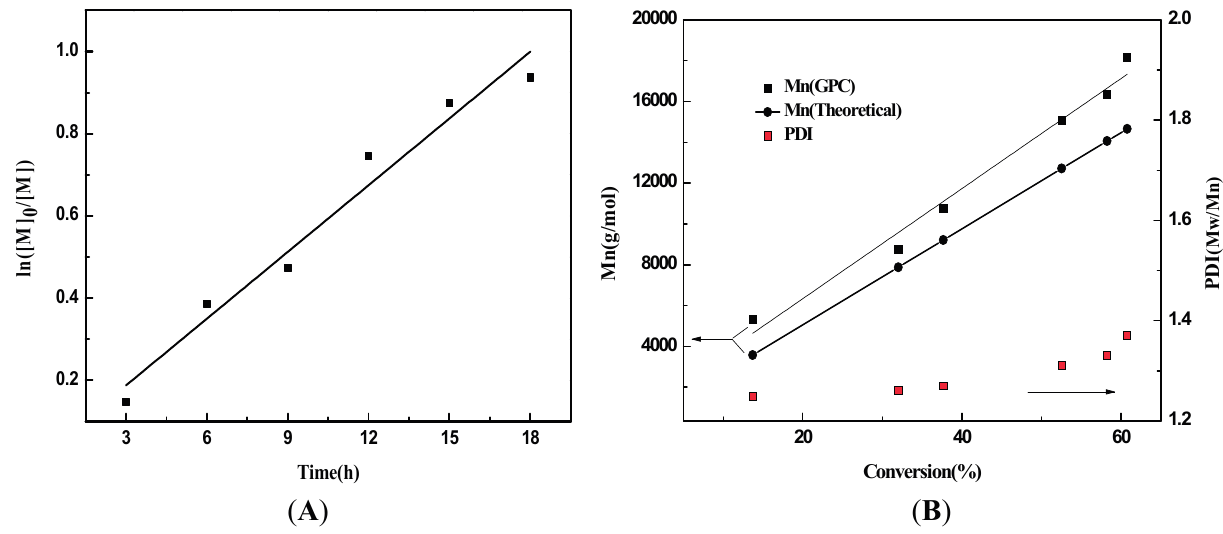
Figure 2. ( A ) Dependence of ln ([M] 0 /[M]) on time (h); ( B ) Relationship of the molecular weights and polydispersity index (PDI) of PDMAEMA macro-chain transfer agent obtained with monomer conversion using AIBN as the radical initiator and CPTCD as the RAFT agent in toluene at 70 °C. DMAEMA/CPTCD/AIBN = 150:1:0.25, C DMAEMA,0 = 2.0